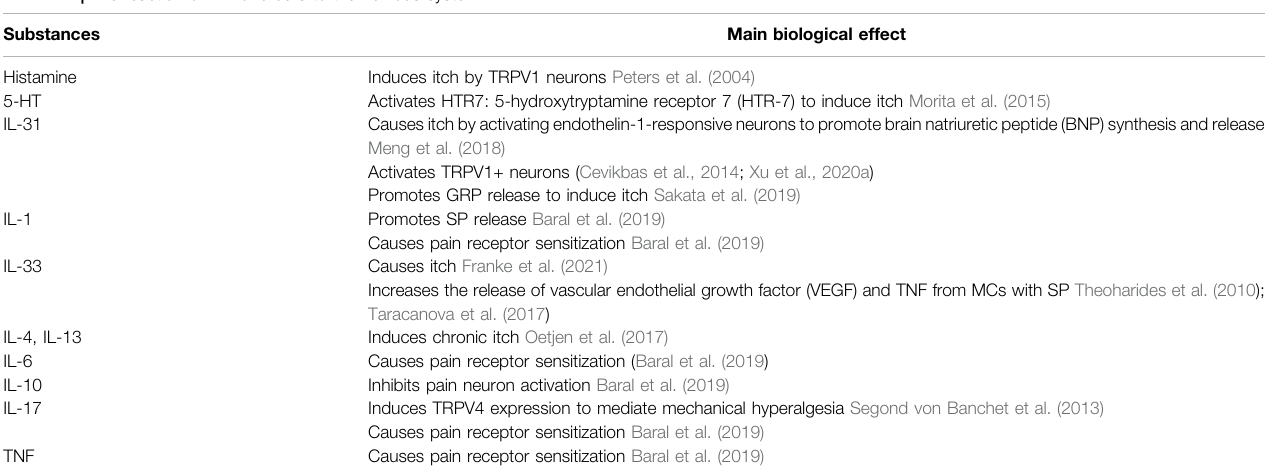
TABLE 2 | The reaction of immune cells to the nervous